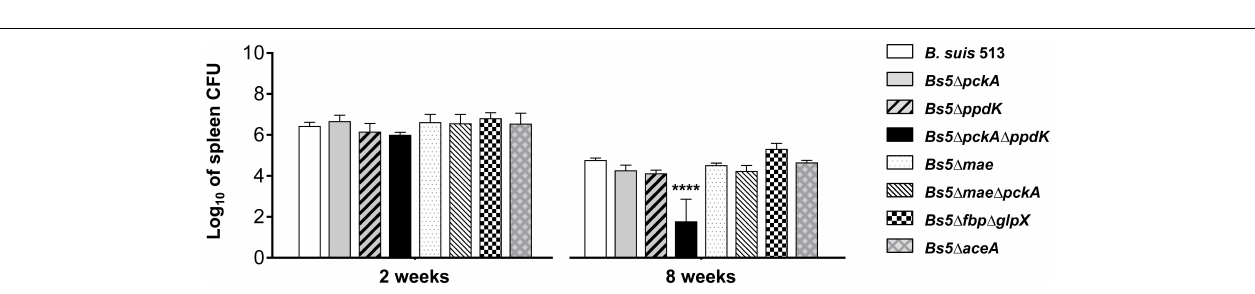
FIGURE 6 | Multiplication of B. abortus 2308W and B. suis 513 in virulence models. (A) Bacterial multiplication in BALB/c mice. Each point is the mean ± standard deviation ( n = 5) of the log CFU per spleen. (B) Intracellular multiplication in RAW 264.7 macrophages (the B. abortus 2308W virB mutant is used as a control of attenuation). Values are mean ± standard errors for triplicate infections and the results shown are representative of three independent experiments.